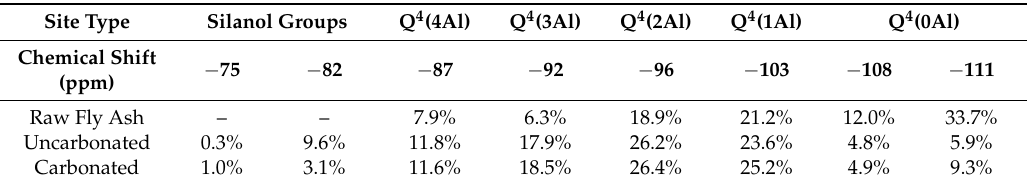
Table 1. Deconvolution results of 29 Si MAS NMR spectra of raw fly ash, uncarbonated and carbonated alkali-activated fly ash. The estimated uncertainty in site percentages is ˘ 1%.